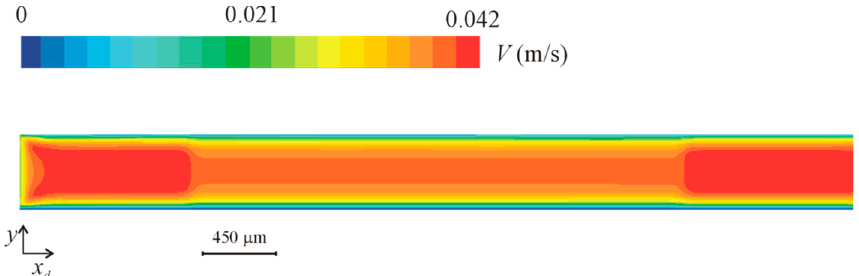
Figure 10. Velocity magnitude in the midplan in the lowered surface region for a nominal wall shear stress of 1 Pa.